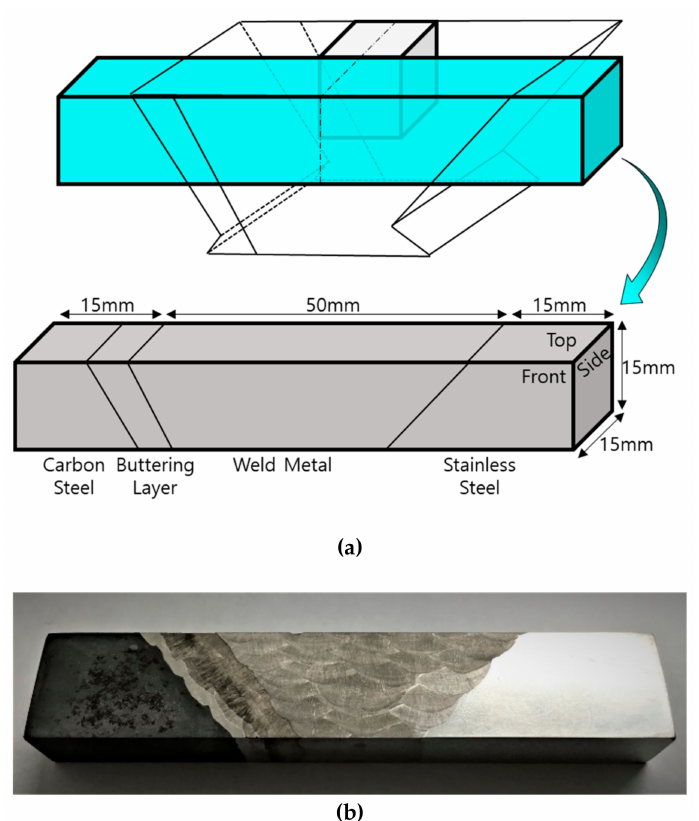
Figure 10. ( a ) Schematic illustration and ( b ) photograph of the dissimilar-metal welds (DMW) specimen.